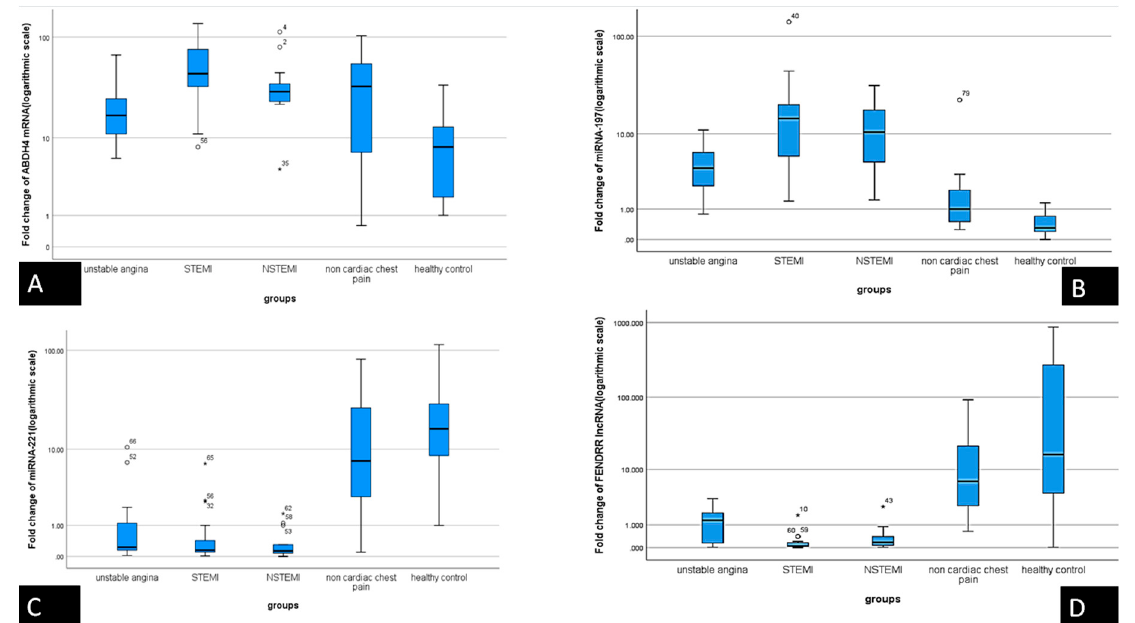
Figure 1. Differential analysis of the results in BOXPLOT represents serum RNA panel expression based on fold change in gene expression at logarithmic scale as measured by qRT-PCR among the groups of the study. ( A ) ABHD4 mRNA , ( B ) MiRNA-197-5p , ( C ) miRNA-221-3p , and ( D ) FENDRR lncRNA. The median is represented by line inside the box while the 1st and 3rd quartiles are represented by the top and bottom lines of the box, respectively, and the 5th and 95th percentiles are at the top and bottom whiskers, respectively. *, ° different markers for “out” values (small circle) and “far out” or as SPSS calls them “Extreme values” (marked with a star). SPSS uses a step of 1.5 × IQR (Interquartile range).